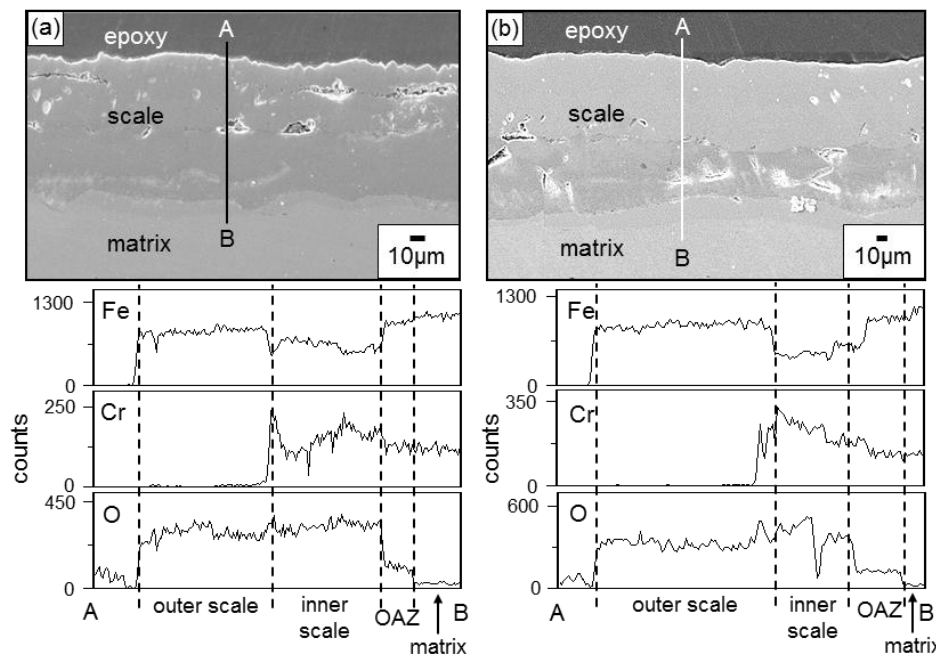
Figure 3. EPMA cross-section and line profiles of Fe-9Cr after corrosion at 700 °C for 70 h in ( a ) N 2 ; and ( b ) N 2 /3.2%H 2 O.